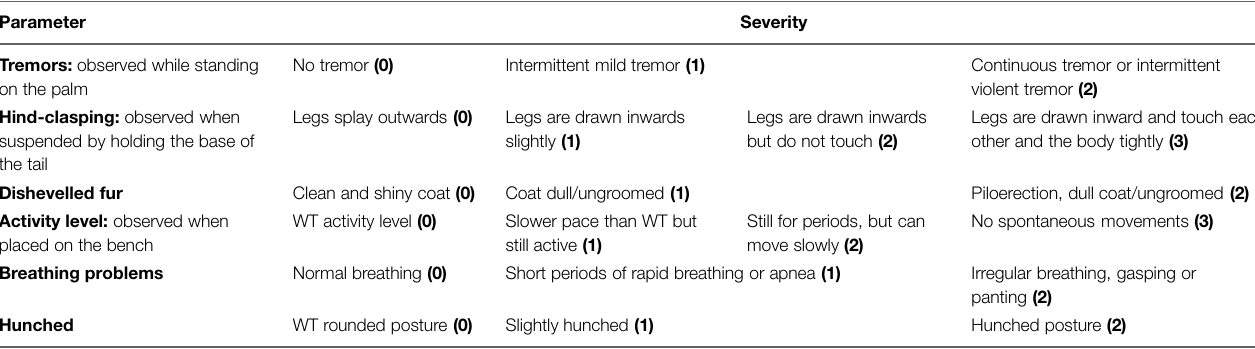
Adapted from (Guy et al.,